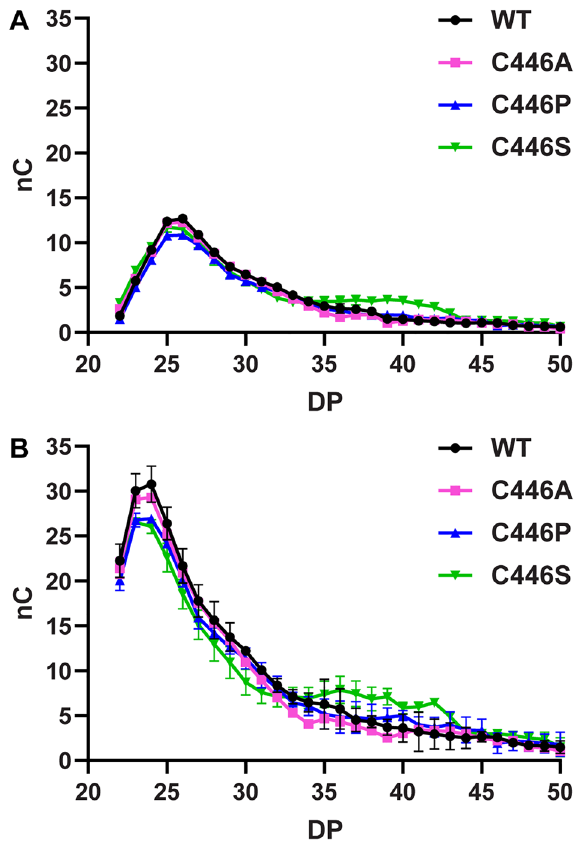
Figure 6. HPAEC-PAD analysis of LR-CD products synthesized at different incubation time: ( A ) 6 h and ( B ) 24 h, by WT and C446 mutated Sa AMs ( nC signal response, DP Degree of